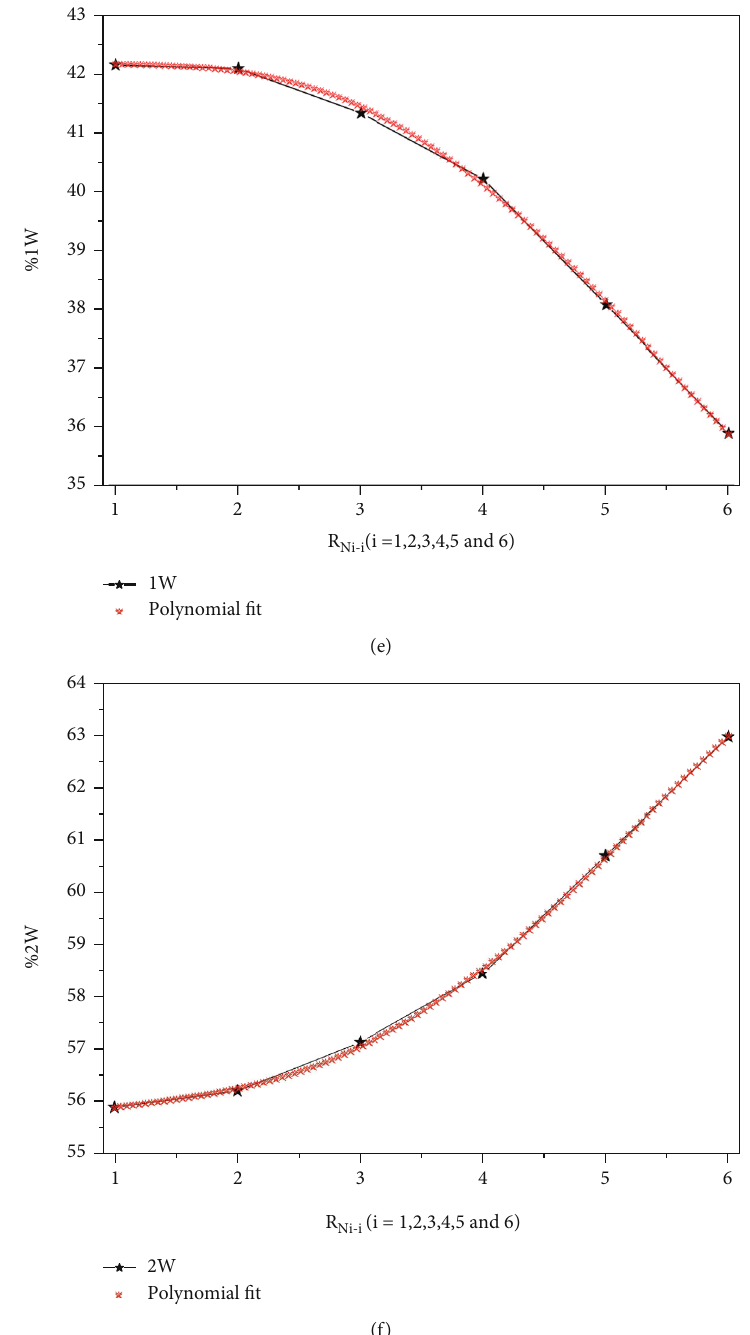
Figure 6: Simulation of 0 W , 1 W , and 2 W amount evolution versus constraint strength. (a) 0 W Ba ; (b) 1 W Ba ; (c) 2 W Ba ; (d) 0 W Ni ; (e) 1 W Ni ; (f) 2 W Ni